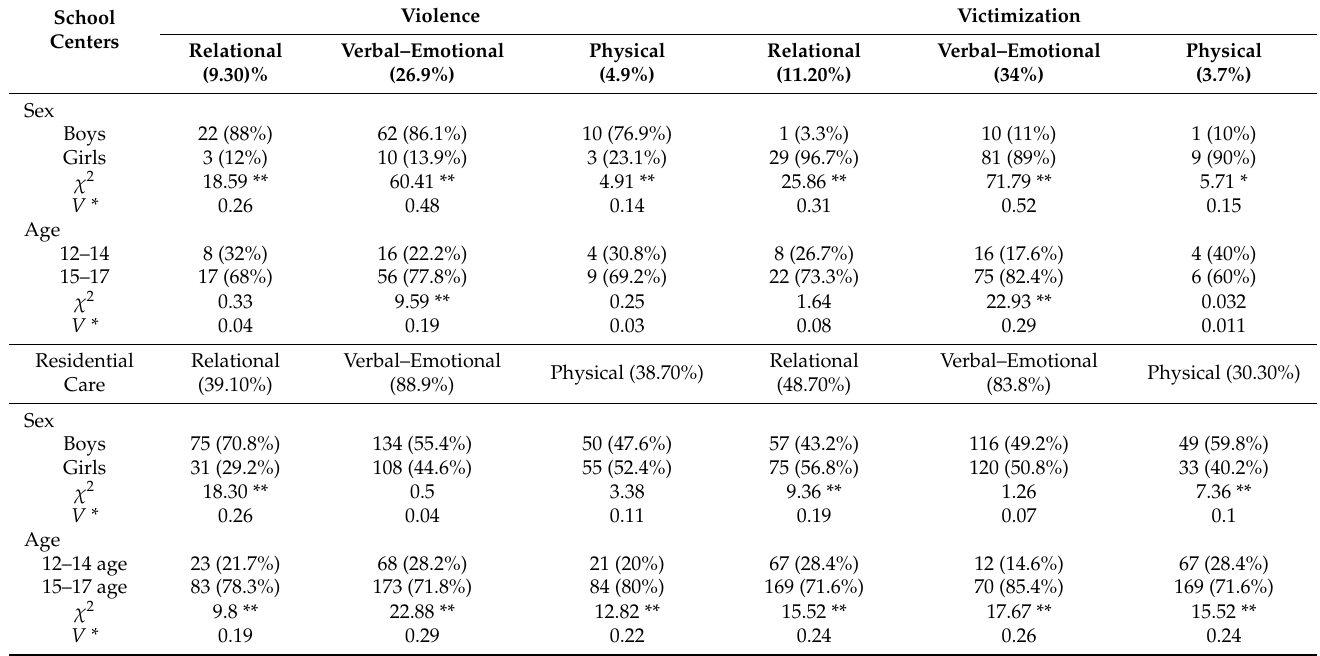
Table 2. Types of DV as a function of sex, age and